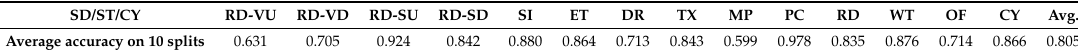
Table 14. Average F 1 accuracy of the SD/ST/CY group.